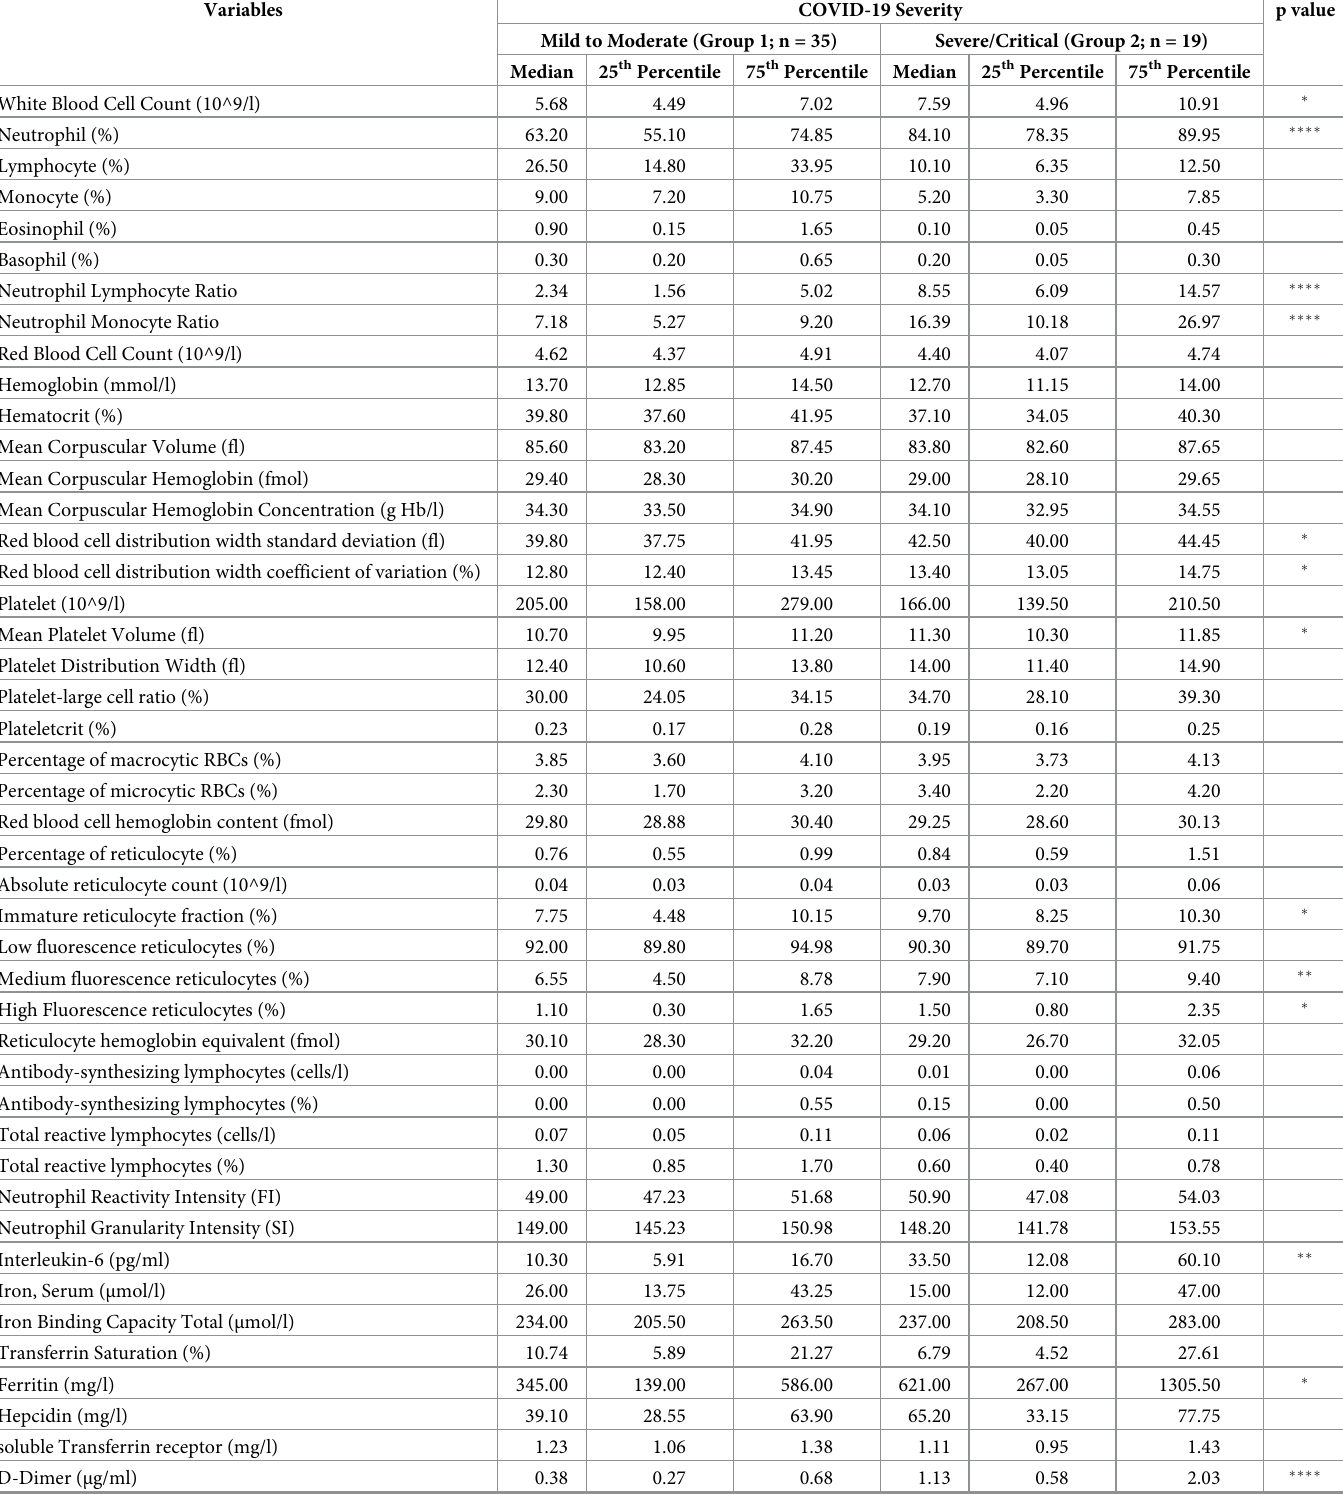
Table 3. Complete blood count and other hematological analysis based on COVID-19 severity ( < 5 days).